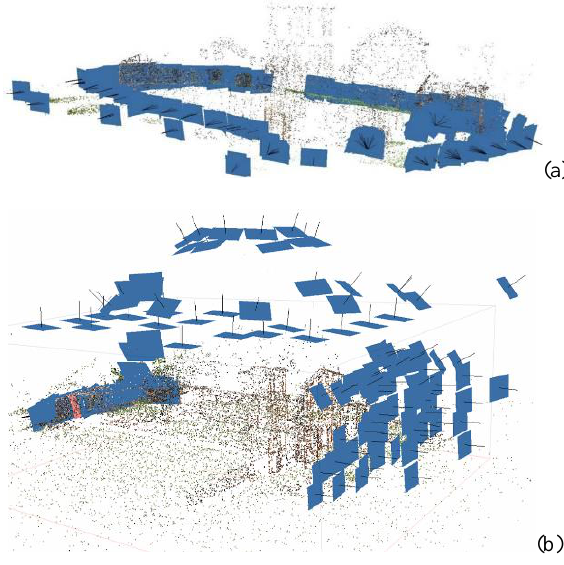
Figure 10 – Acquired Pictures: (a) Terrestrial Camera; (b) micro-UAV Asctec Falcon